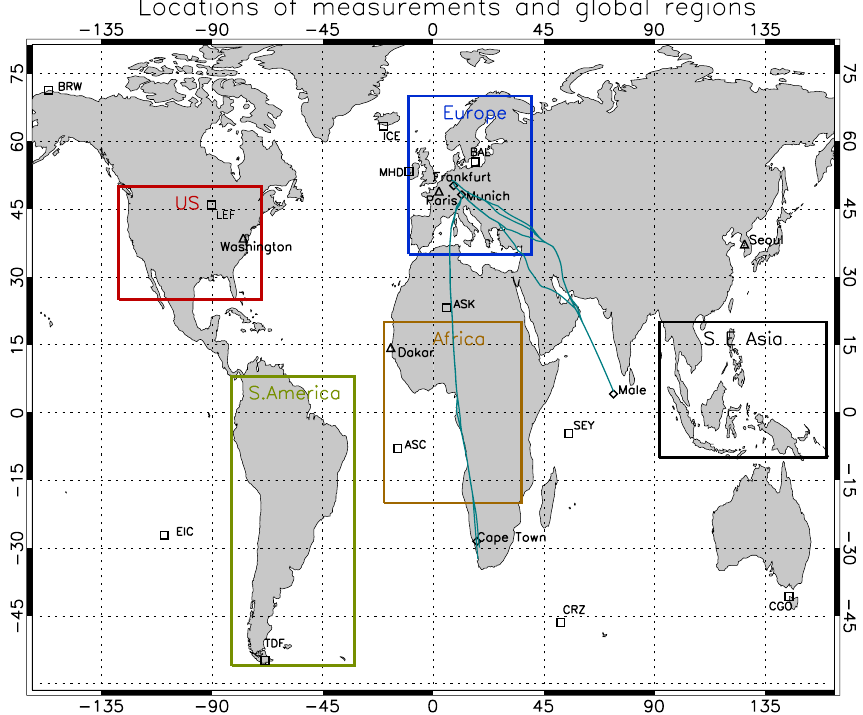
Fig. 1. Definition of global regions used for analysis of the differences in the global biogenic emission climatologies. Also shown are the location of the sampling sites for the measurements used in the study from MOZAIC ( 1 ), GMD ( (cid:3) ), CARIBIC (metallic blue lines). For clarity the EMEP stations used are not shown by reside on mainland Europe in Finland, Germany, France and Spain.